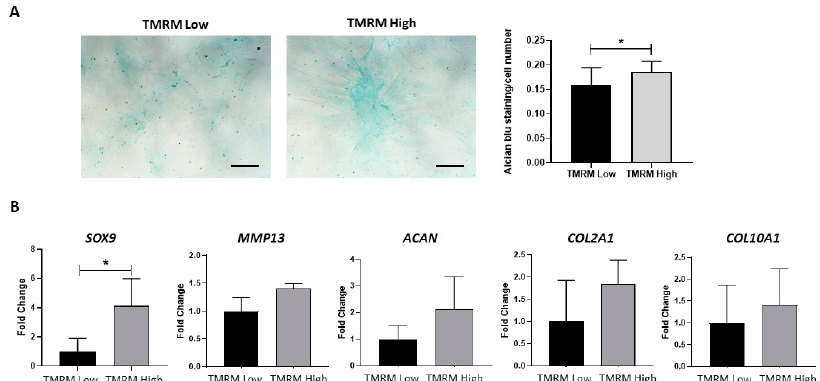
Figure 9. In vitro chondrogenic differentiation of TMRM-low and high cells. ( A ) The culture in pro-chondrogenic conditions for 2 weeks favored increased in sGAG synthesis, as evidenced by Alcian blue staining (left panel). Bar graph shows the relative quantification (right panel). ( B ) Expression of early and late genes involved in chondrogenesis SOX9 : SRY-box transcription factor 9, MMP13 : matrix metallopeptidase 13, ACAN : aggrecan, COL2A1 : collagen type II alpha 1 chain and COL10A1 : collagen type X alpha 1 chain. n = 3 per group. Data are represented as mean ± SD of the fold change. n = 3 per group. Statistical differences were calculated significant as * p < 0.05, determined by Student’s t-test.